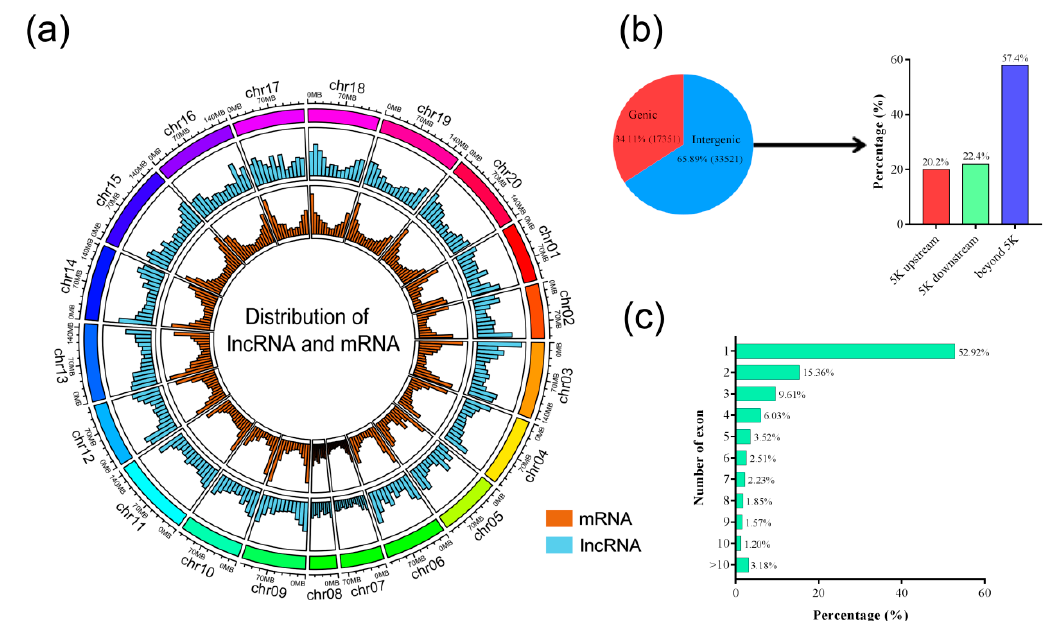
Figure 2. Characteristics of peanut lncRNAs. ( a ) Distribution of lncRNAs and mRNA along each chromosome. The abundance of lncRNA and mRNA in physical bins of 10 Mb for each chromosome (generated using Circlize). ( b ) Proportion of lncRNAs that are located within 5 kb (upstream or downstream) or further than 5 kb from the nearest protein-coding genes. ( c ) Numbers of exons in lncRNA.